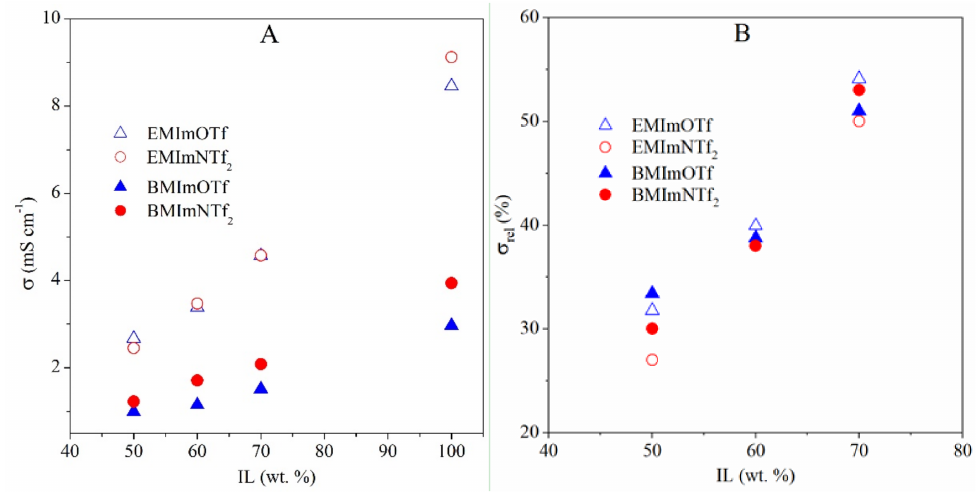
Figure 6. Dependence of ( A ) conductivity, σ , and ( B ) relative conductivity, σ rel , on the IL content in the ionogels. Residual standard deviations of σ and σ rel values are below 3%.